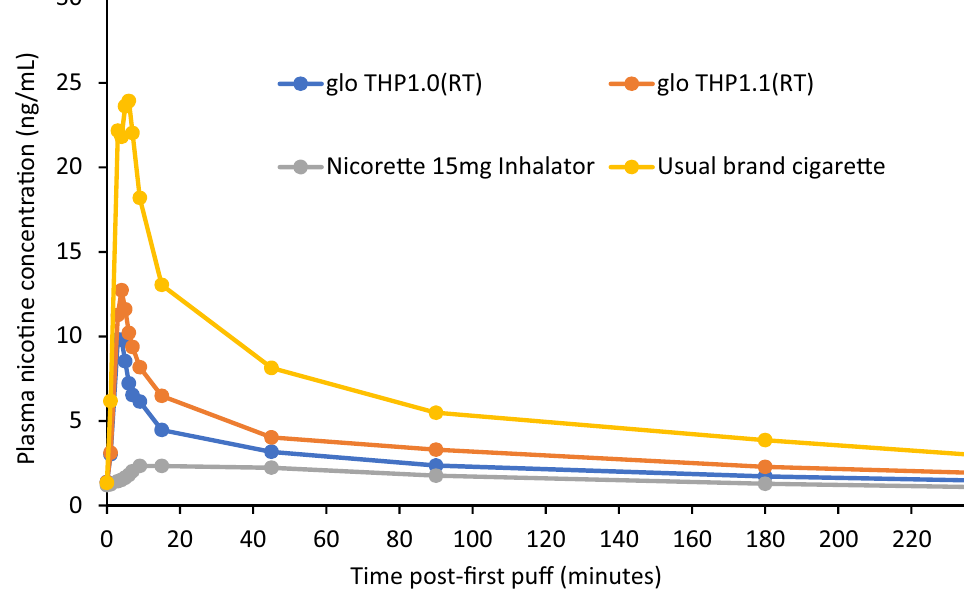
Figure 2. Mean plasma nicotine concentrations at each timepoint. Seven subjects were excluded from the PK analysis population due to major protocol deviations (washout problem), therefore n = 30 for usual brand cigarette, n = 31 for glo THP1.0(RT), n = 30 for glo THP1.1(RT) and n = 30 for Nicorette 15 mg Inhalator.